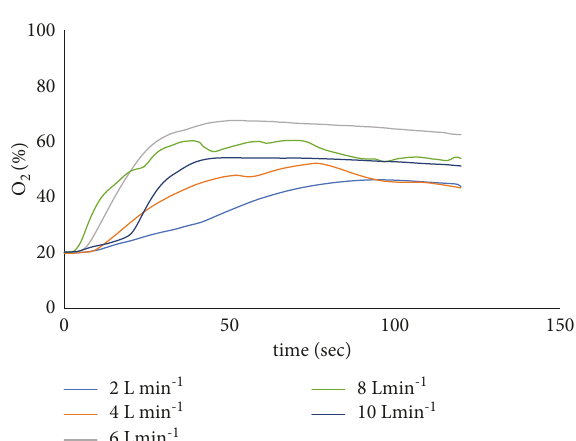
Figure 4: Oxygen purity as a function of time for different flowrates, input pressure 2.5bar, and height of packing